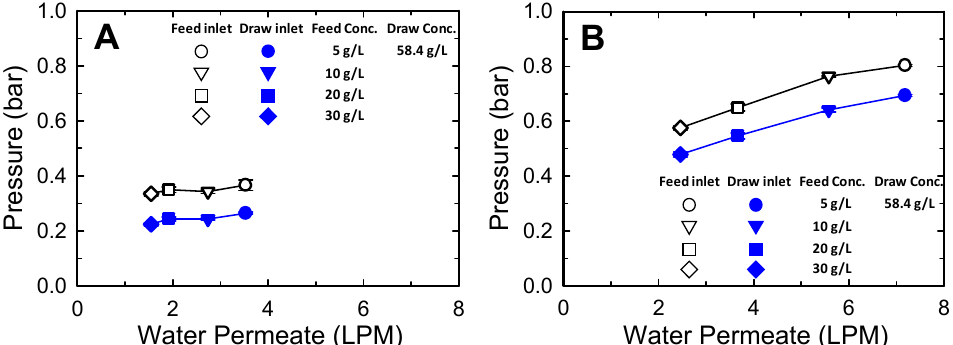
Figure 3. E ff ect of water permeate flow on feed and draw inlet pressures of spiral-wound FO. One ( A ) and three ( B ) SW FO membranes connected in series were used. Water permeate was adjusted by varying the feed concentration to 5, 10, 20, and 30 g / L. A draw solution with a concentration of 58.4 g / L (1 M) NaCl was used. The flow rates of the feed and draw solutions were maintained at 10 LPM in all tests. The error bars represent one standard deviation.